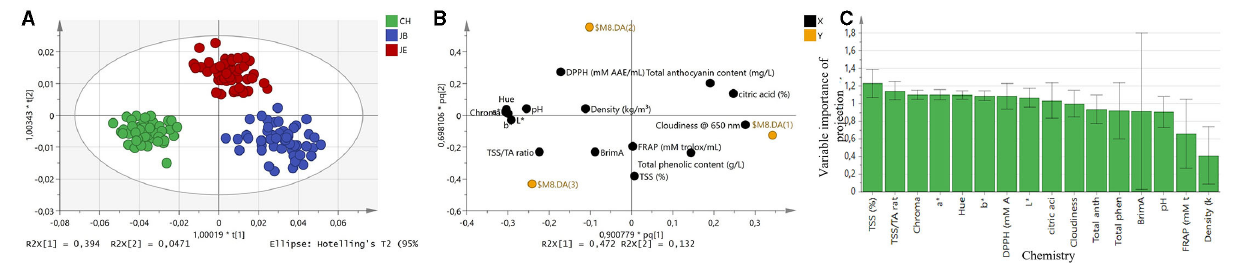
FIGURE 3 | (A) The orthogonal partial least squares discriminant analysis score plot for all spectra n = 150. (B) Score plot representing extraction methods and associated chemistry. (C) Variable importance of projection (VIP) summarizing reference data is responsible for model performance. Color coded based on the type of extraction method. Green, commercial hand press juicer (CH); blue, juice blender (JB) (crushing the arils with the seeds); and red, juice extractor (JE) (extract juice from arils without crushing the